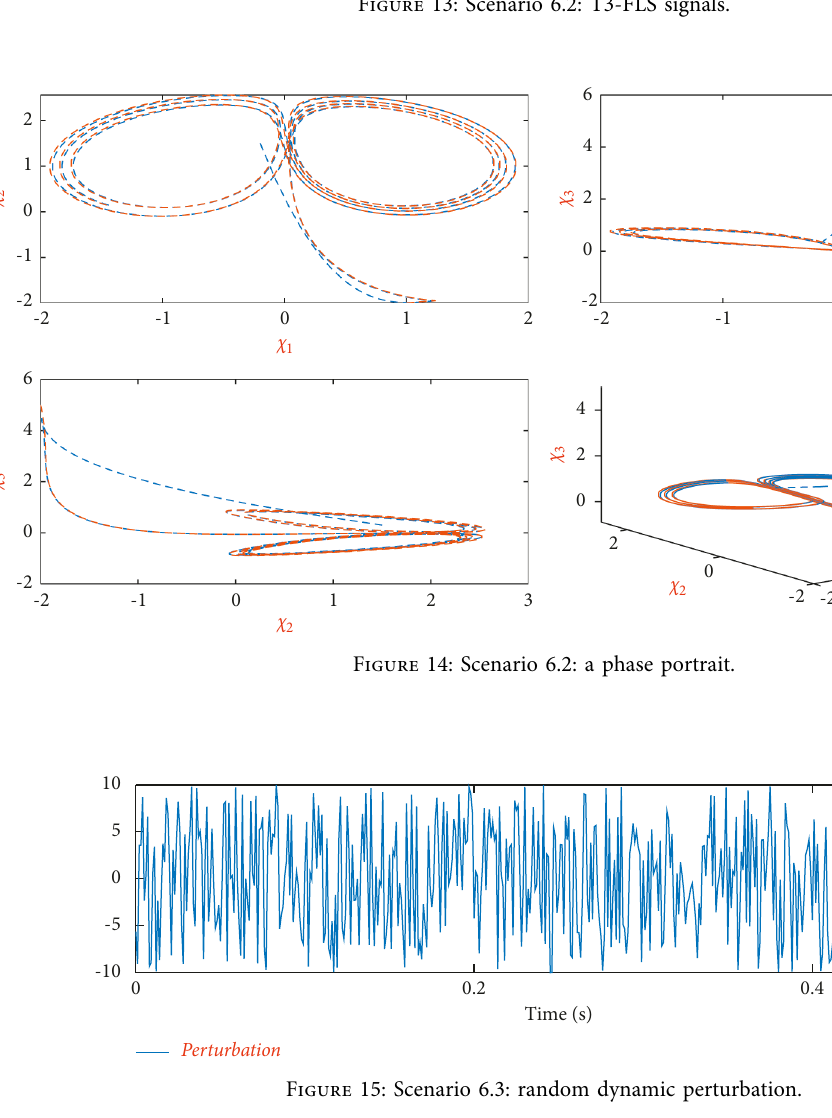
Figure 13: Scenario 6.2: T3-FLS signals.